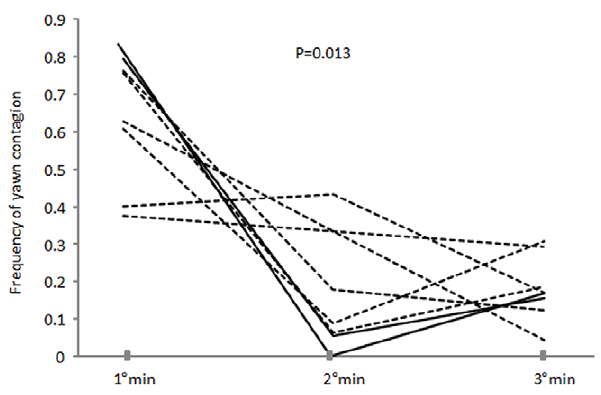
Figure 2. Individual frequency of yawn contagion as a function of the minute of observation. Dotted lines represent females, full lines represent males.